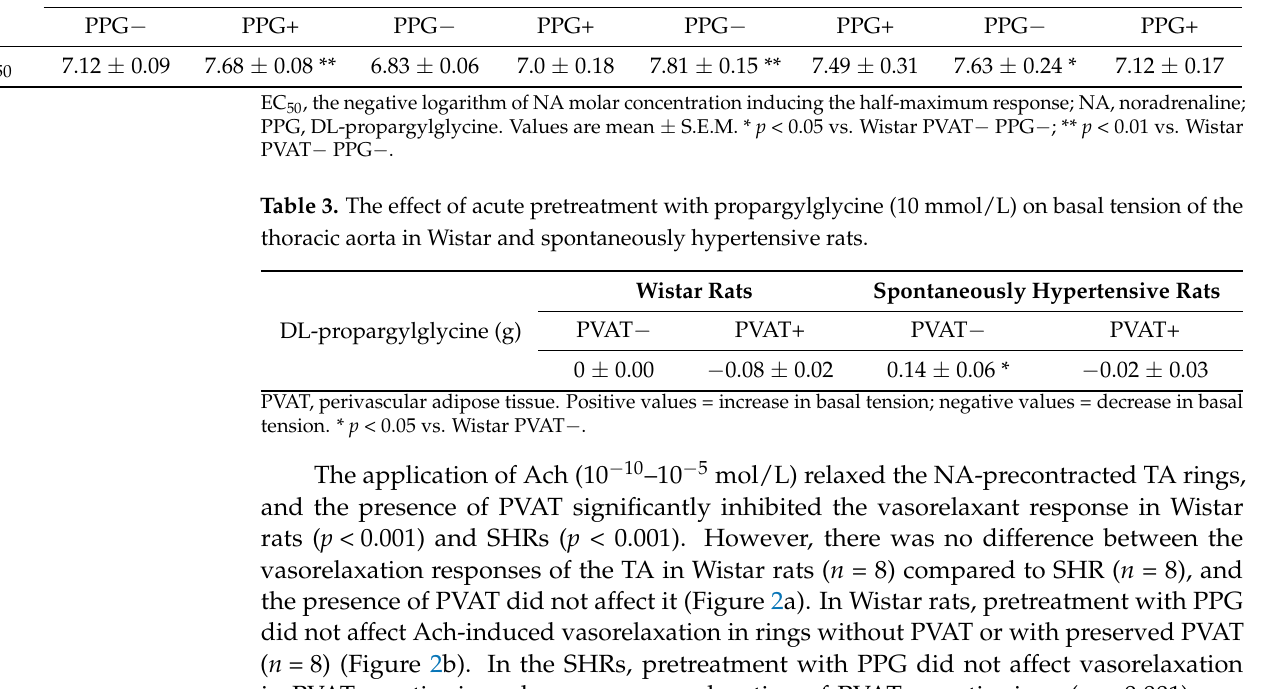
Table 2. Sensitivity of the thoracic aorta of Wistar and spontaneously hypertensive rats to noradrenaline. Wistar Rats Spontaneously Hypertensive Rats PVAT − PVAT+ PVAT − PVAT+ PPG − PPG+ PPG − PPG+ PPG − PPG+ PPG − PPG+ EC 50 7.12 ± 0.09